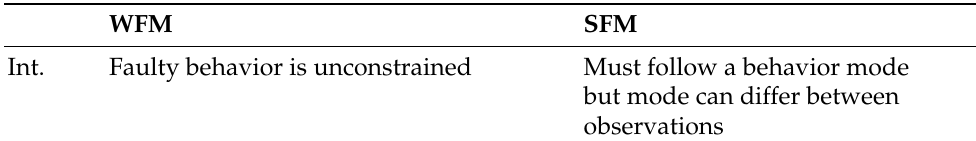
Table 1. A summary of a component’s faulty behavior in the different configurations of WFM/SFM and